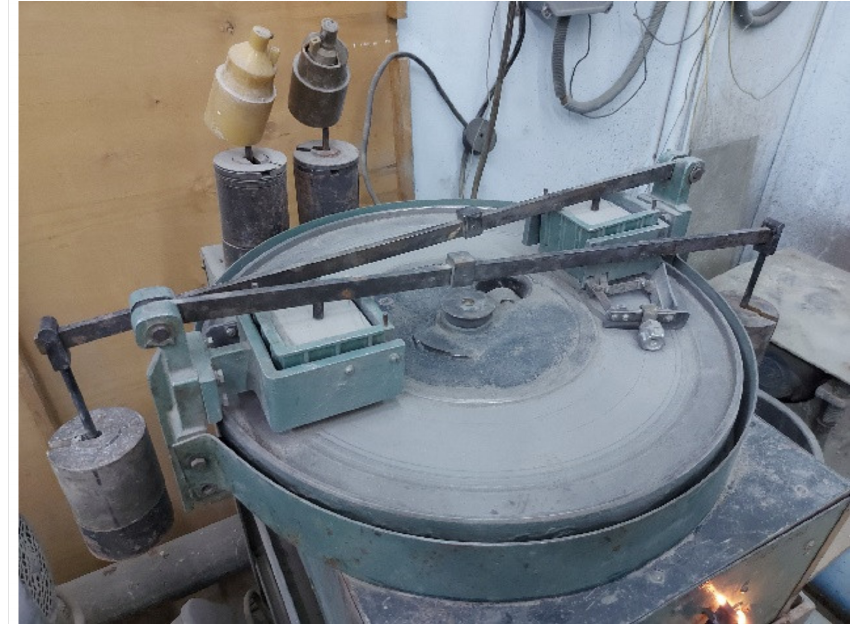
Figure 6. Abrasion resistance test. Composition samples No. 5 on a wheel